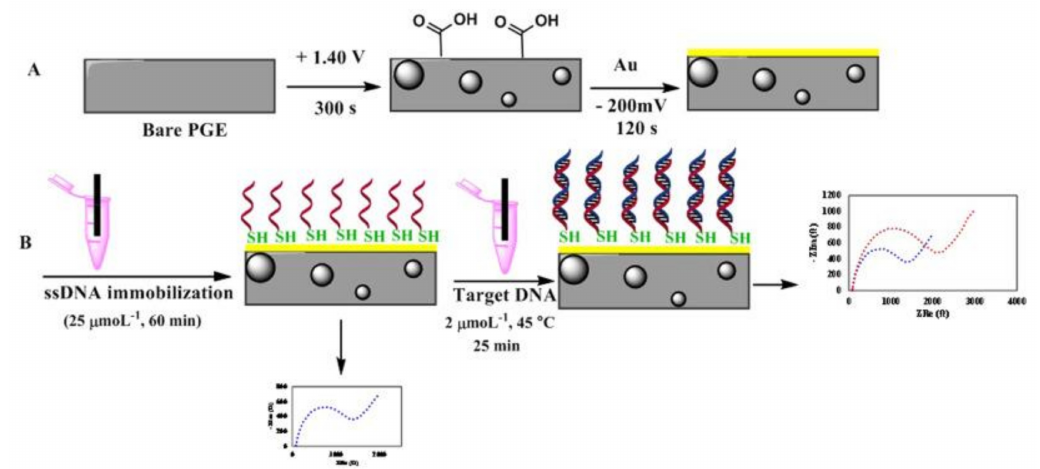
Figure 7. Schematic presentation of the immobilization of the ssDNA on a pencil graphite electrode modified with nano-gold ( A ) and its hybridization with B. cereus genomic DNA ( B ) (Reprinted with Permission from